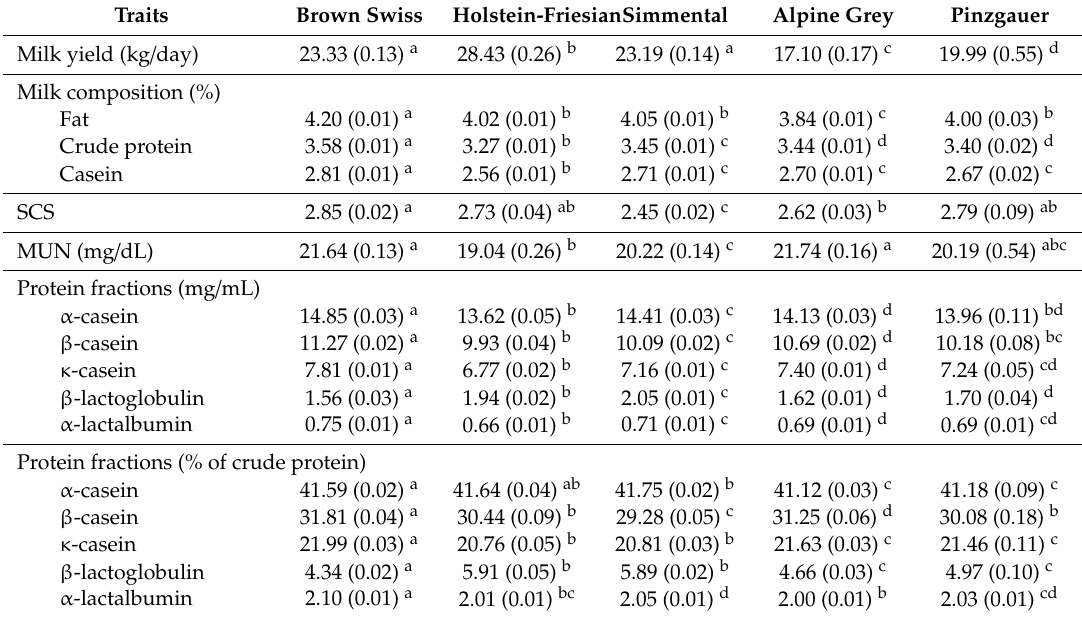
Table 2. Least squares means (SE in parentheses) of milk yield, milk composition, somatic cell score (SCS), milk urea nitrogen (MUN) and detailed protein composition of di ff erent cow breeds 1